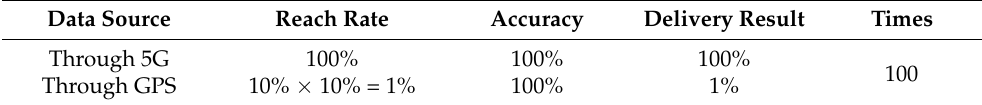
Table 19. Comparison of delivery effectiveness on single members’ street